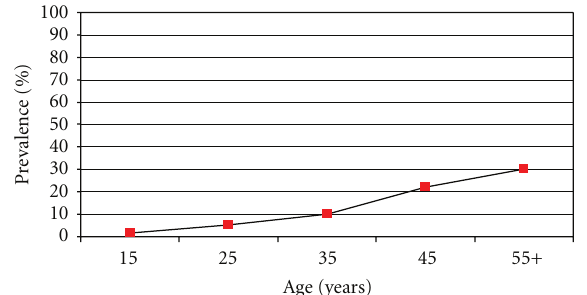
Figure 1: Prevalence of hypertension (%) by age in Saudi Arabia 2005.